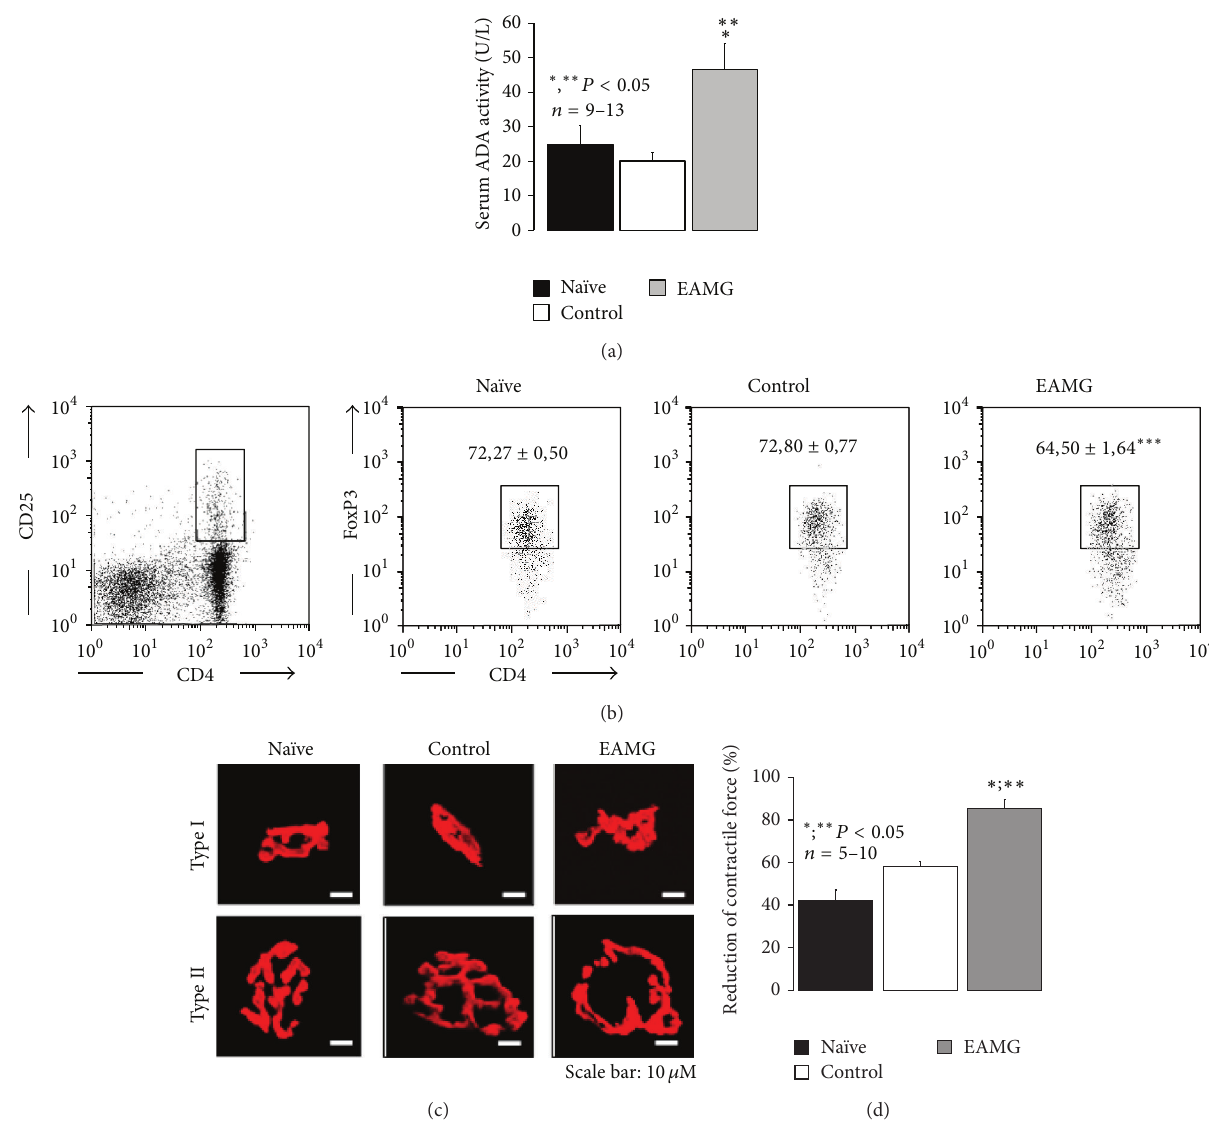
Figure 1: Neuromuscular and immunological deficits of rats with EAMG. Experiments were performed six weeks after immunization with the peptide R97-116 corresponding to the 𝛼 -subunit of nAChR in CFA (EAMG), as compared to age-matched na¨ıve and control littermates. (a) Measurement of serum adenosine deaminase (ADA) activity. Results are mean ± SEM of 9 na¨ıve, 13 control, and 12 EAMG rats. ∗ , ∗∗ 𝑃 < 0.05 (one-way ANOVA following Dunnett’s modified 𝑡 -test) compared to na¨ıve and control animals, respectively. (b) Flow cytometry analysis of intracellular FoxP3 expression in CD 4 + CD 25 + T cells collected from popliteal and inguinal lymph nodes from na¨ıve, control, and EAMG rats. Gating strategy to delimit CD 4 + CD 25 + cells is shown on the left dot plot. Dot plots on the right show FoxP3 expression within gated CD 4 + CD 25 + cells. Gate inside these dot plots correspond to FoxP3 + cells. Dot plots are a representative example of each indicated group. Numbers inside dot plots correspond to mean percentage ± SEM of FoxP3 + cells within CD 4 + CD 25 + population. Statistically significant difference between EAMG ( 𝑛 = 13 ) and both na¨ıve ( 𝑛 = 9 ) and control ( 𝑛 = 13 ) groups is indicated ( ∗∗∗ 𝑃 < 0.001 ; one-way ANOVA and Bonferroni’s post hoc test). (c) Confocal microscopy micrographs showing type I and type II motor endplates from hemidiaphragm sections labeled with TMR- 𝛼 -BTX (red) from na¨ıve, control, and EAMG animals. Scale bar: 10 𝜇 m. (d) Reduction of contractile strength of isolated hemidiaphragm preparations from na¨ıve, control, and EAMG animals during a 3 min period of intermittent phrenic nerve stimulation (17 pulses per second delivered at 50 Hz frequency). Results are mean ± SEM of 10 na¨ıve, 6 control, and 5 EAMG rats. ∗ , ∗∗ 𝑃 < 0.05 (one-way ANOVA following Dunnett’s modified 𝑡 -test) compared to na¨ıve and control animals,